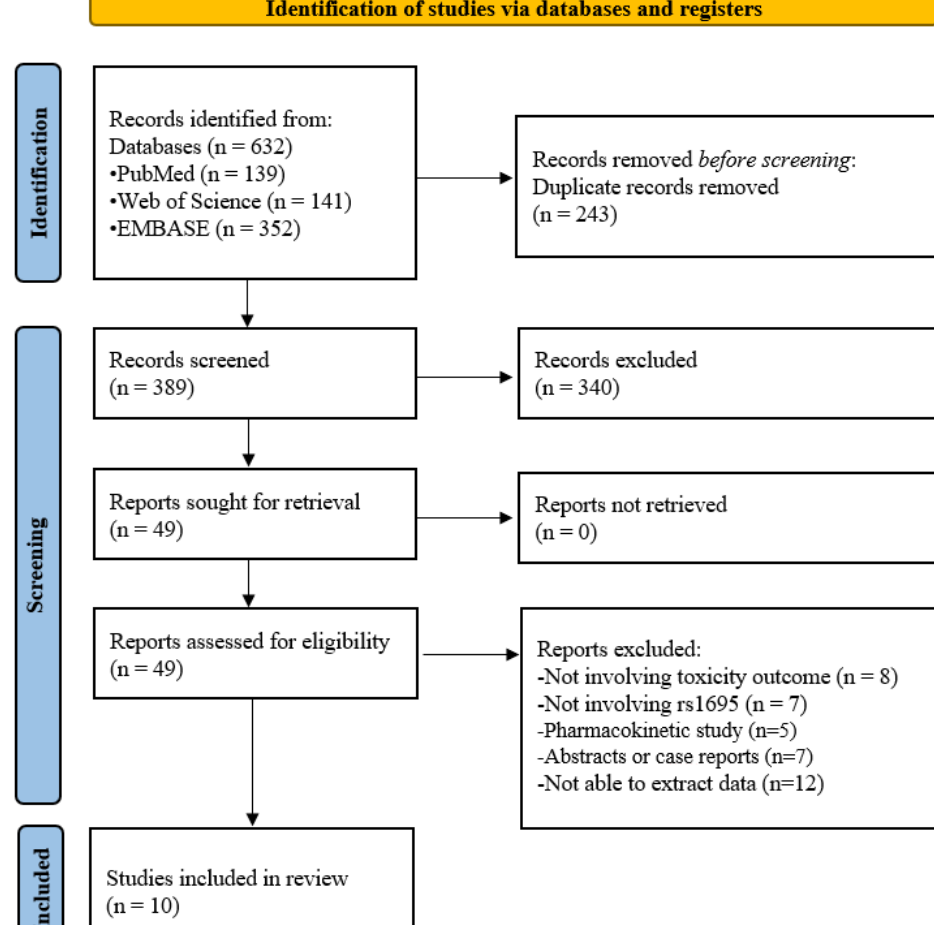
Figure 1. Flow diagram of the study selection process.